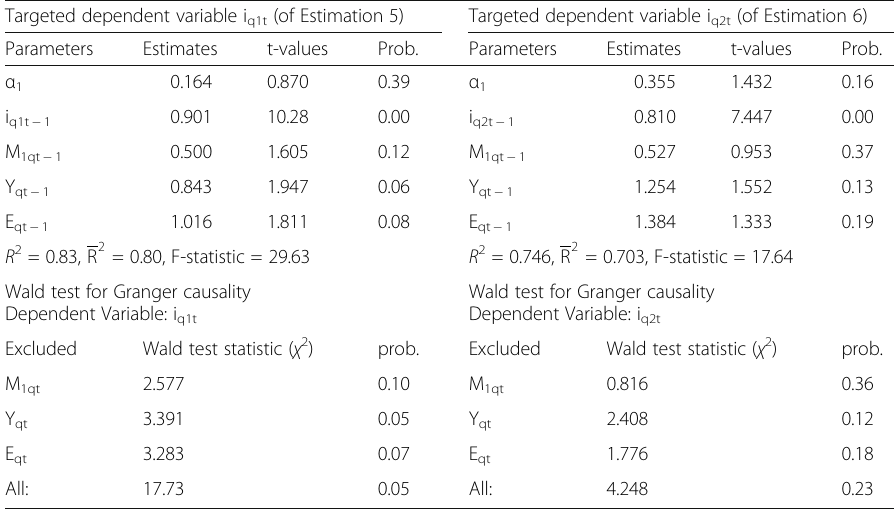
Table 5 Dynamics of interest rates involving quarterly dataset (M1 money growth is used) Targeted dependent variable i q1t (of Estimation